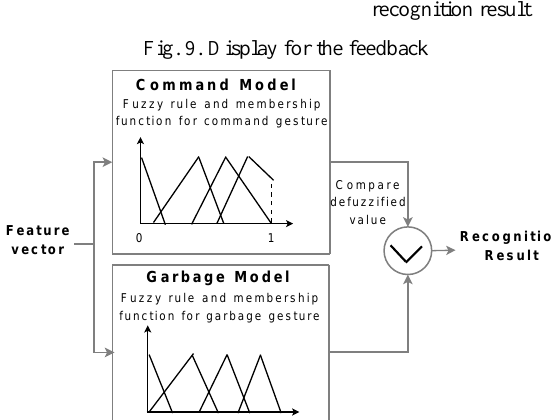
Fig. 10. Command gesture recognition by fuzzy garbage model